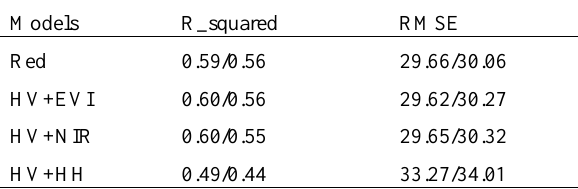
Table 3. The correlation of determination (R 2 ) and Root mean squared error (RMSE) in biomass estimation models using the entire data and Leave-one-out cross-validation (LOOCV).